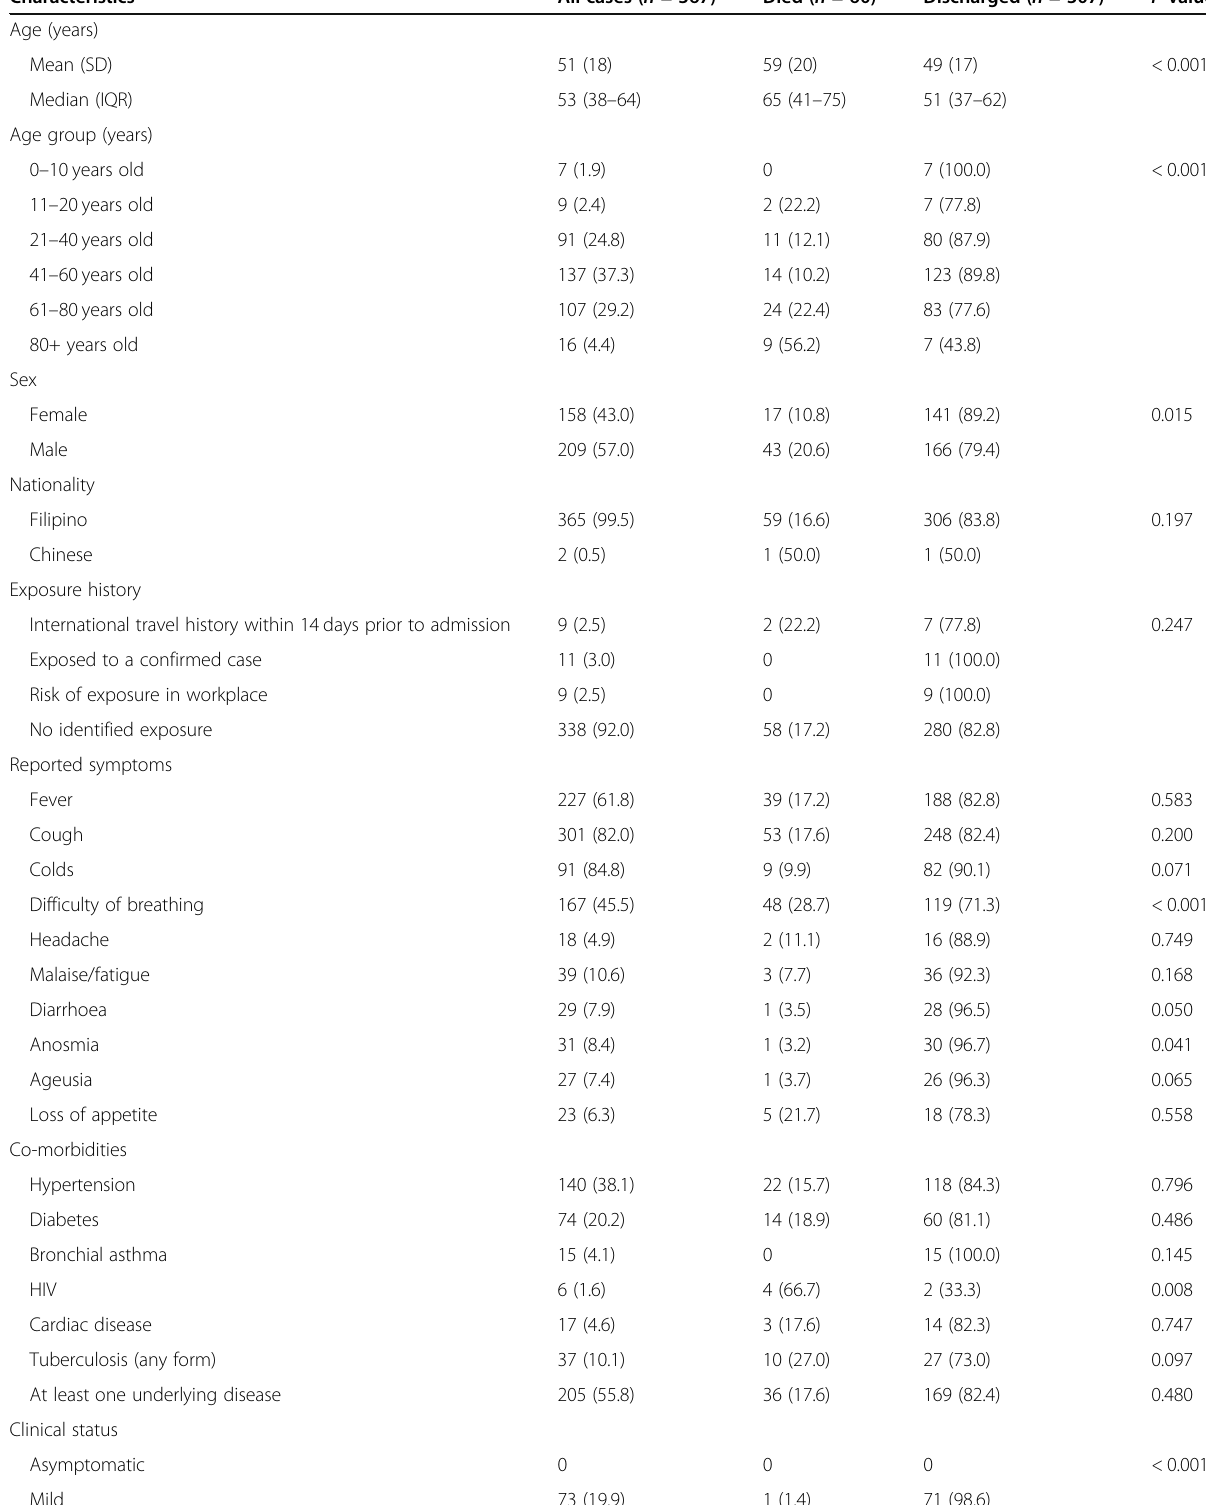
Table 2 Associations with mortality among 367 non-HCW COVID-19 inpatients in San Lazaro Hospital, January to October 2020